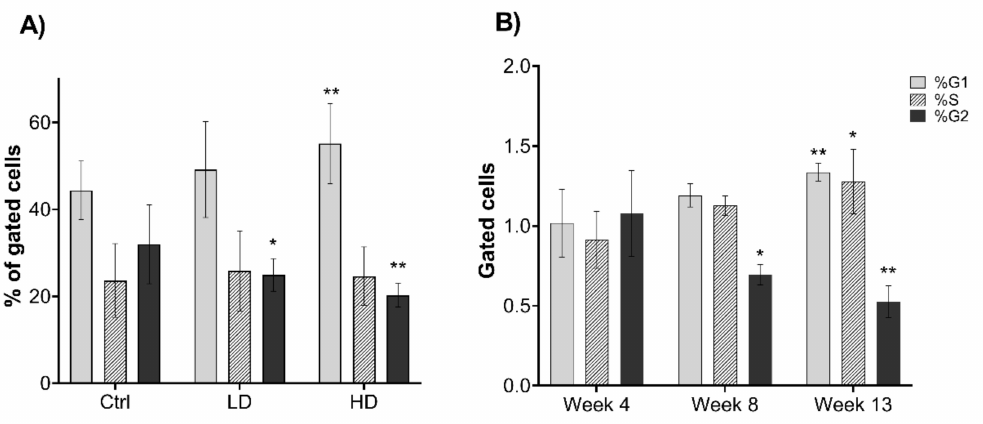
Figure 2. Effects of TiO 2 exposure on cell cycle distribution. Cell cycle was analyzed by flow cytometry at 4, 8 and 13 weeks of continuous exposure. Single cells were gated. ( A ) Merged data of all weeks measured, presented as % of gated cells, ( B ) merged LD and HD data are shown as number of gated cells normalized to control cells (Ctrl), compared to week 4. Low dose (LD): 0.96 µ g/cm 2 and high dose (HD): 1.92 µ g/cm 2 . Data indicate mean ± SEM, (A: n = 6, B: n = 4). * p < 0.05, ** p < 0.01 obtained from linear mixed model